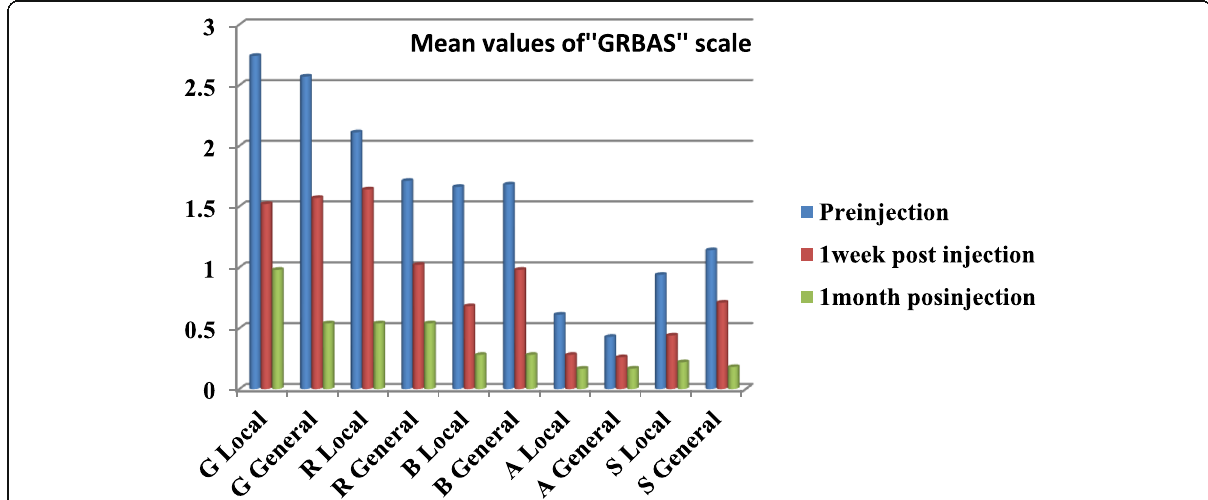
Fig. 3 Results of modified GRBAS scale among the studied patients by local and general